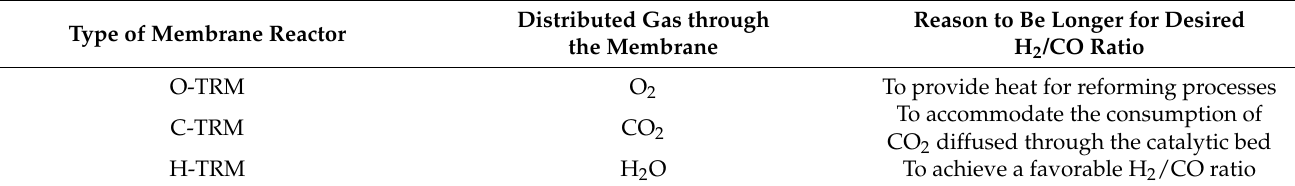
Table 5. Different types of micro-porous membrane reactors and the reason why they should be longer compared to conventional reactors